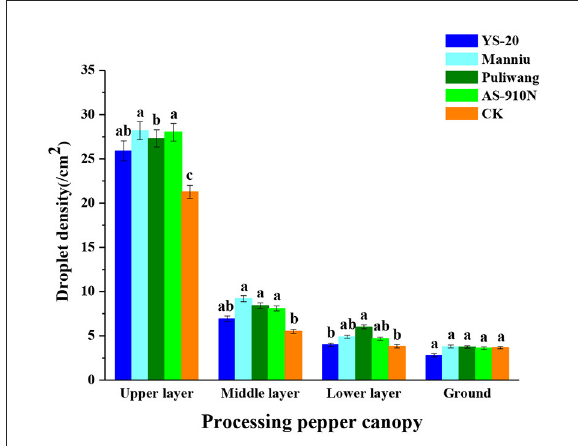
FIGURE6 Effect of aerial spray with adjuvants on the droplet coverage sprayed by UAV. a − c They represent the results of a significant difference analysis by Duncan’s new multiple range test at the level of P < 0.05. Values followed by the same letter do not differ